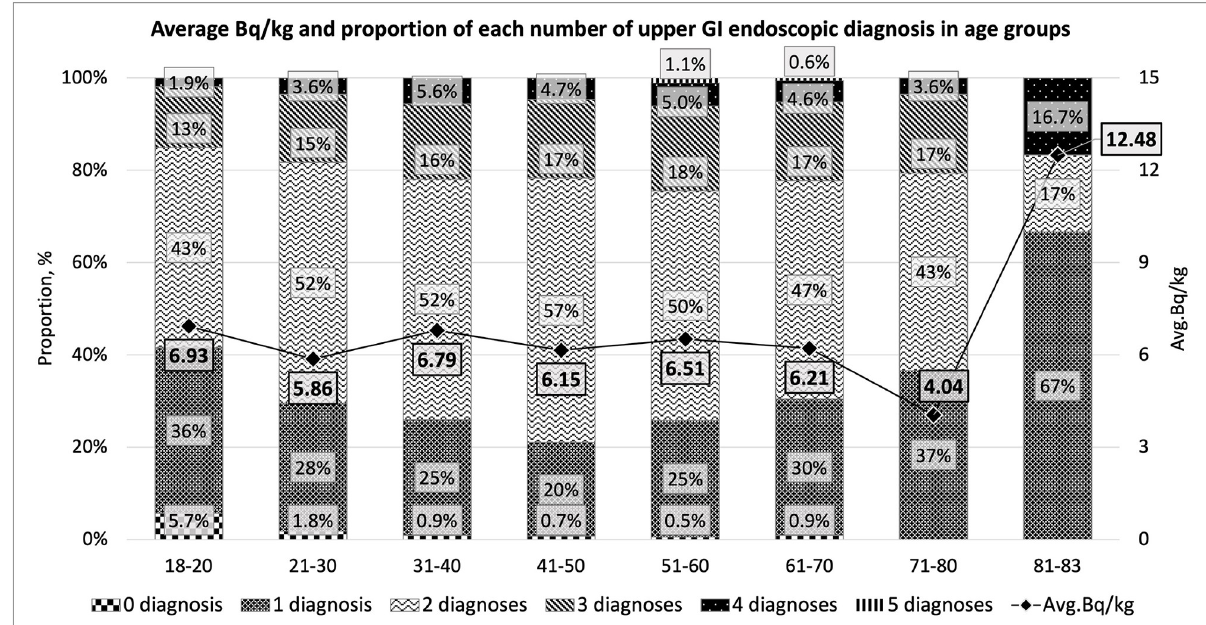
Fig 2. Average Bq/kg and proportion of number of upper GI endoscopic diagnosis in each age group. The stretched line throughout all age ranges indicates the average Bq/kg detected in respective age groups. The number of upper GI endoscopic diagnosis and proportions increased with age, although the average Bq/kg was not